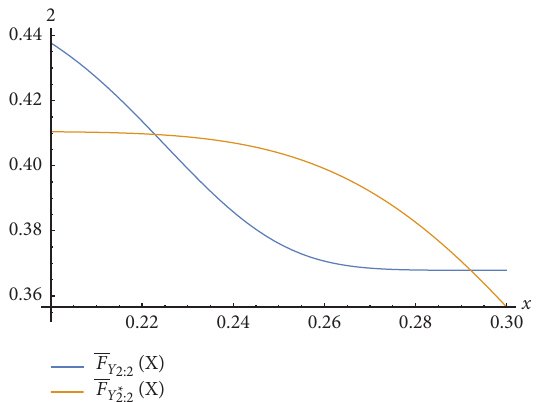
Figure 2: Plots of survival functions F